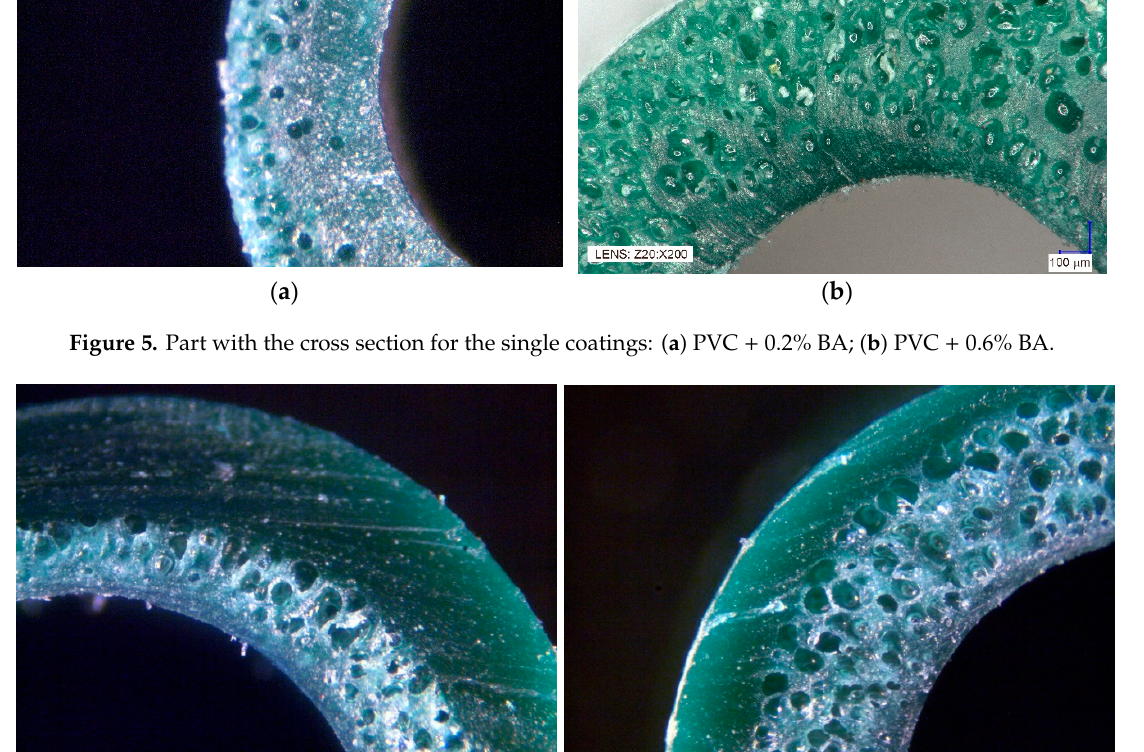
Figure 5. Part with the cross section for the single coatings: ( a ) PVC + 0.2% BA; ( b ) PVC + 0.6% BA.